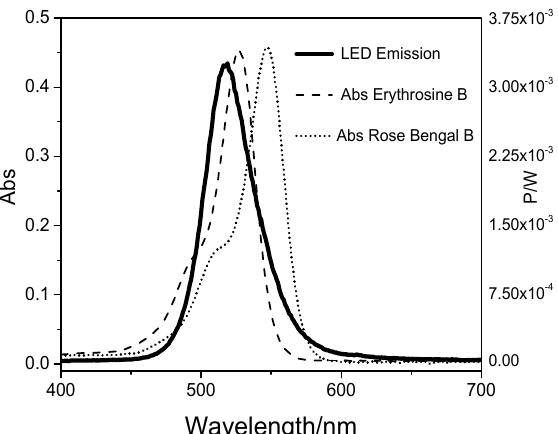
Figure 1. Light-emitting diode emitted potency (P LED emitted) and absorbed potency (P Abs ) by ERY and RB.